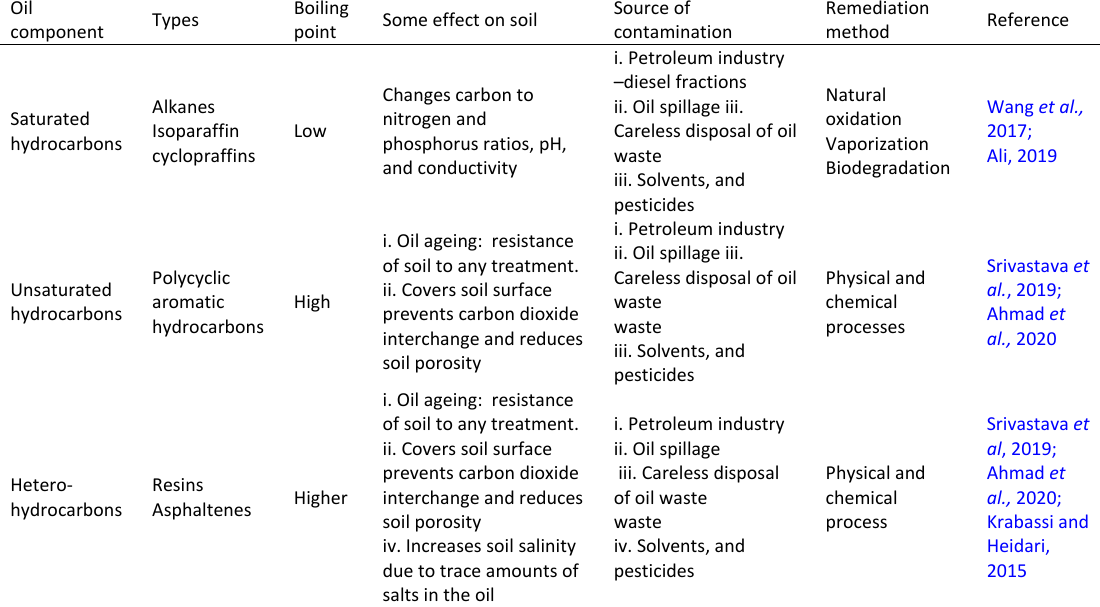
Table 1: A summary of oil components, effect on the soil and the type of remediation